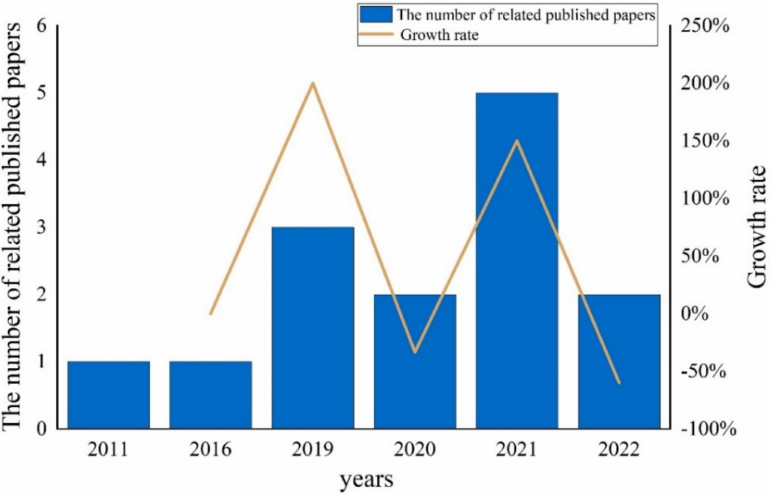
Figure 3. Statistics of published paper on human–robot-collaboration